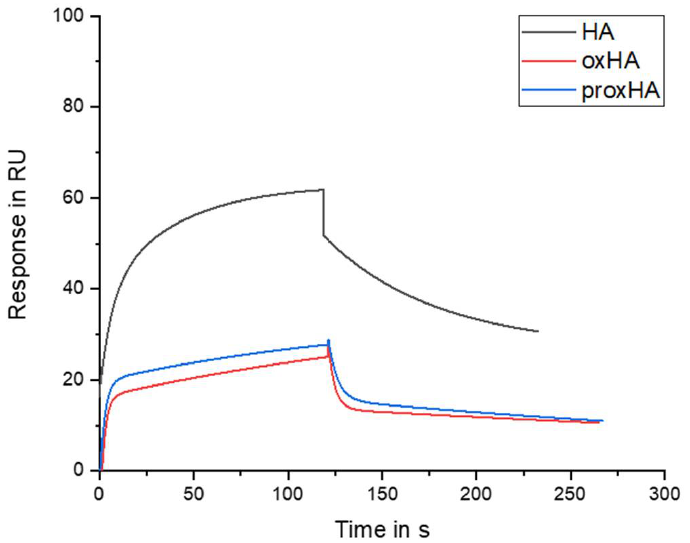
Figure 5. SPR analysis of: (black) unmodified HA; (red) NaIO 4 oxidized (oxHA); (blue) TEMPO/TCC oxidized (proxHA), at the highest investigated concentration of 32.7 µM.